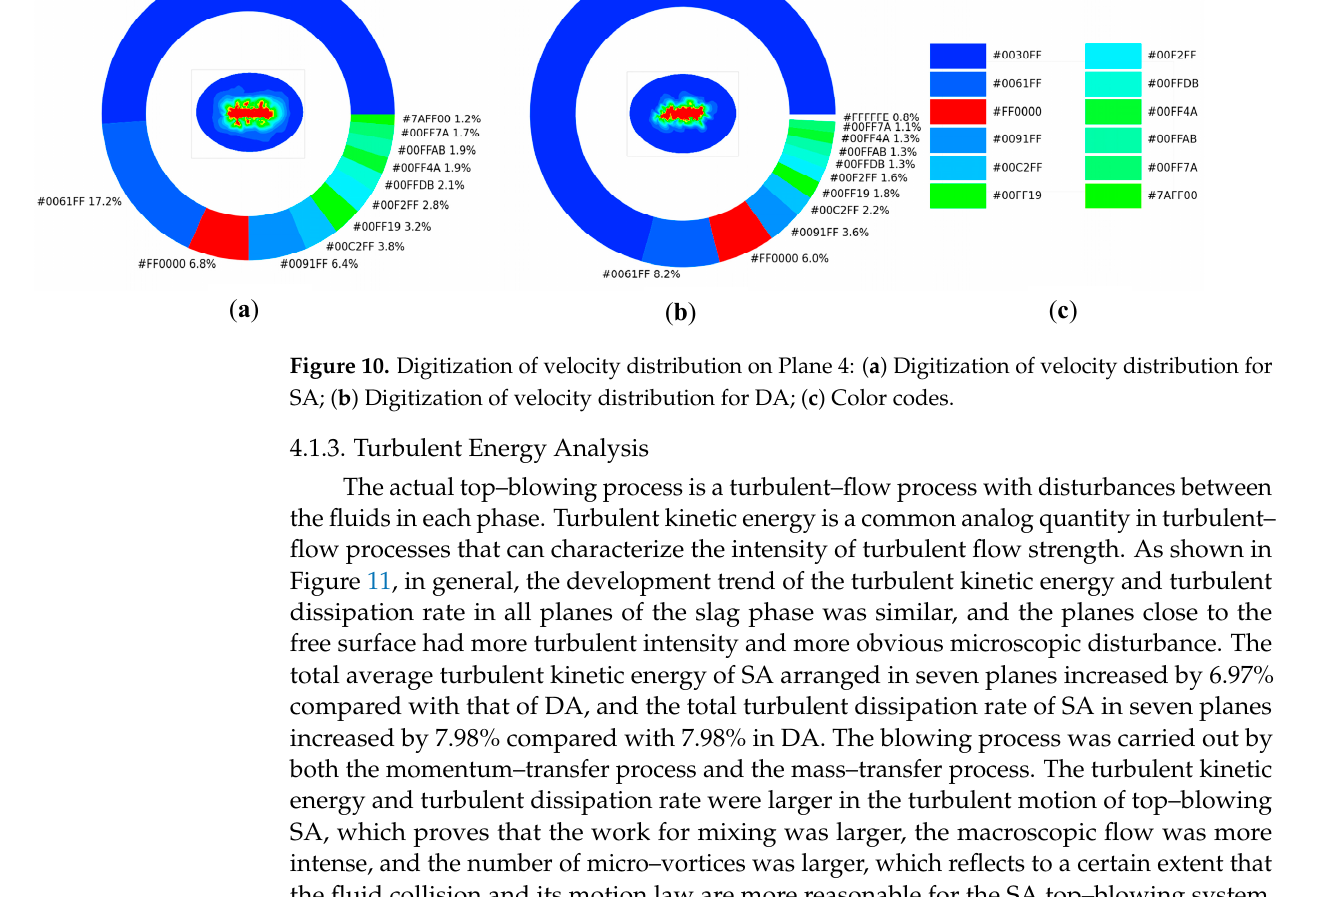
Figure 10. Digitization of velocity distribution on Plane 4: ( a ) Digitization of velocity distribution for SA; ( b ) Digitization of velocity distribution for DA; ( c ) Color codes.